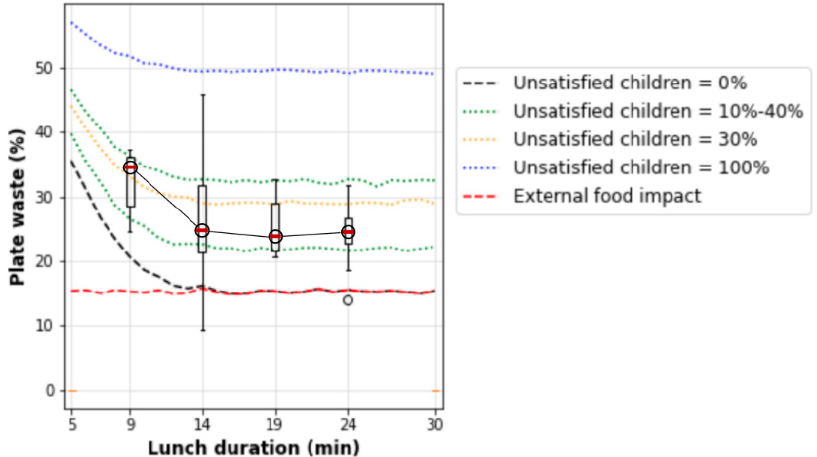
Figure 10. Simulation results intersected with the observed plate waste per week per class, where the boxplots are the observed plate waste.